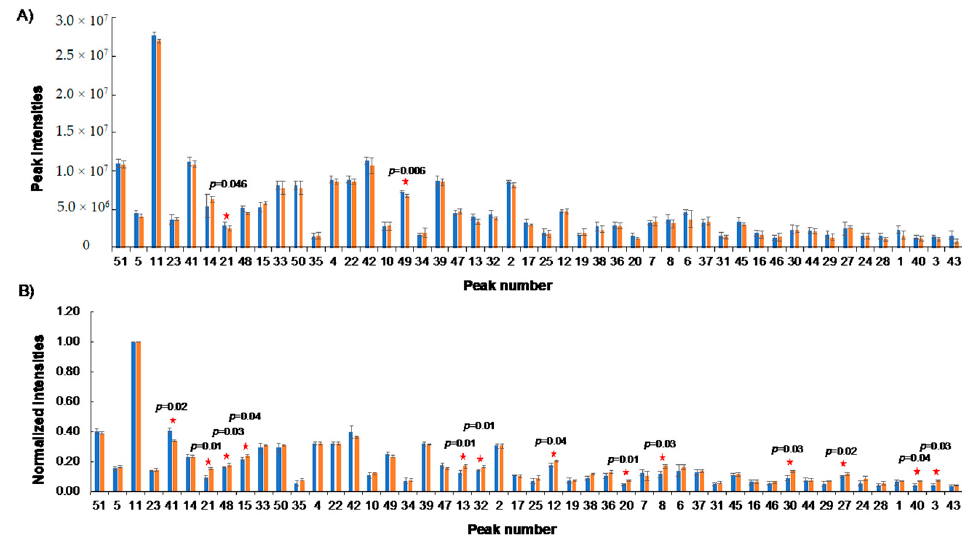
Figure 4. NUS HSQC is highly stable. ( A ) Comparison between absolute peak intensities of two sets of replicate spectra collected 21 days apart. Two peaks with significant difference in intensity ( p < 0.05) are marked with a star. ( B ) Comparison between normalized peak intensities of two sets of replicate spectra collected on two 600-MHz NMR instruments. Significant differences in intensity ( p < 0.05) are marked with a star.